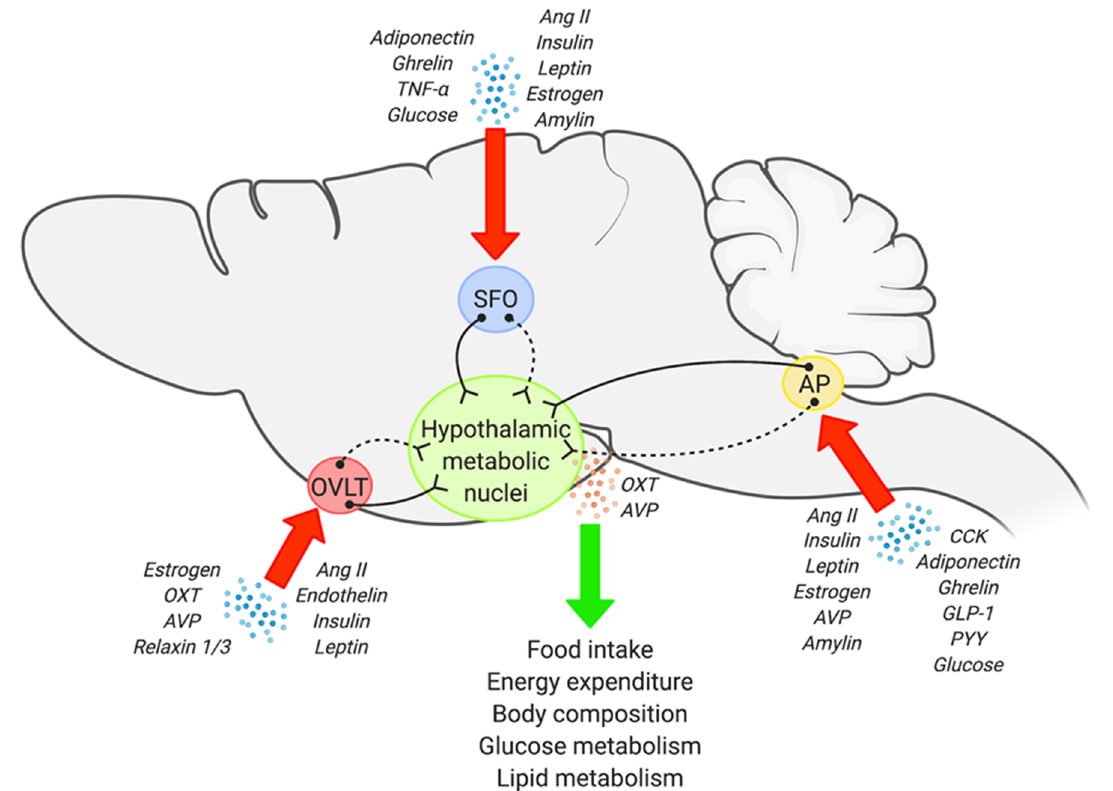
Figure 1. Schematic illustration showing potential sensory CVO-hypothalamic networks involved in metabolism regulation. Each of the sensory CVOs possesses the cellular machinery to sense multiple metabolic factors, a few of which are shown in the image. At the same time, sensory CVOs also establish direct (solid line) as well as indirect synapses (dashed line) to hypothalamic metabolic nuclei including the PVN and SON. Multiple investigations have demonstrated the involvement of the sensory CVOs in metabolism regulation, and further suggest that hypothalamic AVP and oxytocin (OXT) may play a key role. Image was created with Biorender.com.